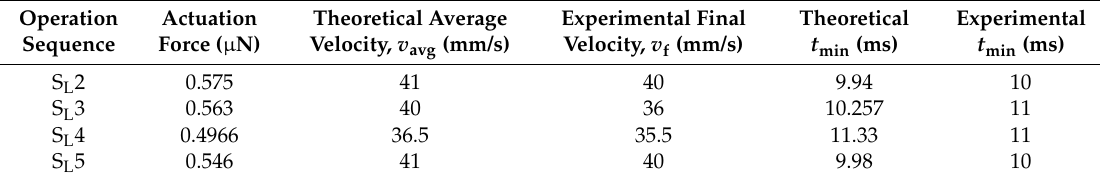
Table 3. Comparison between theoretical calculation (rigid body model) and experimental results for slender electrodes.